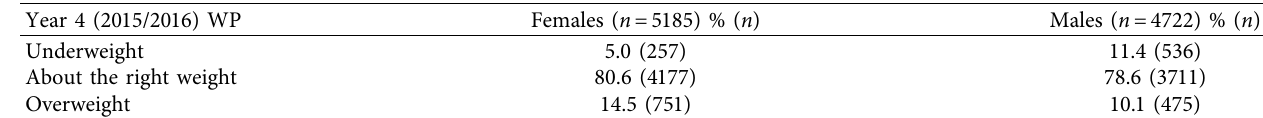
Figure 1: One-year change in weight perception (WP) among grade 9–12 students in the COMPASS study (percentage of WPs reported in Year 4 (2015/2016) by WPs reported in Year 3 (2014/2015)). Table 2: Weight perceptions (WPs) in Year 4 (2015/2016) of the COMPASS study among grade 9–12 students with Year 3 (2014/2015) WPs of “about the right